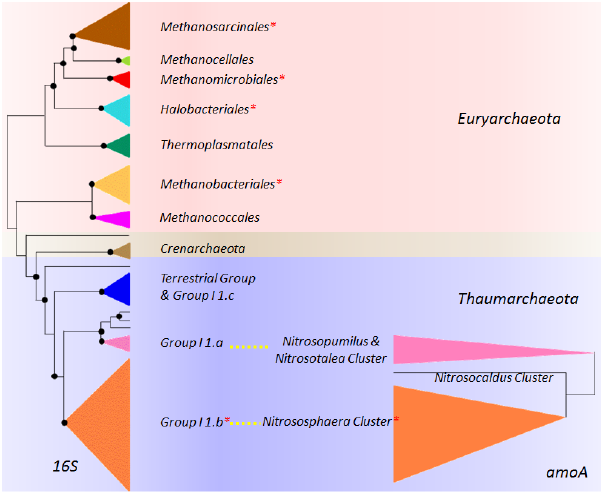
Figure 1. Species richness of airborne archaea. Relative propor- tions of different phyla ( Thaumarchaeota and Euryarchaeota ) and, within the Euryarchaeota , of different orders for continental air, Mainz (a) , and coastal air, Cape Verde (b) , respectively.